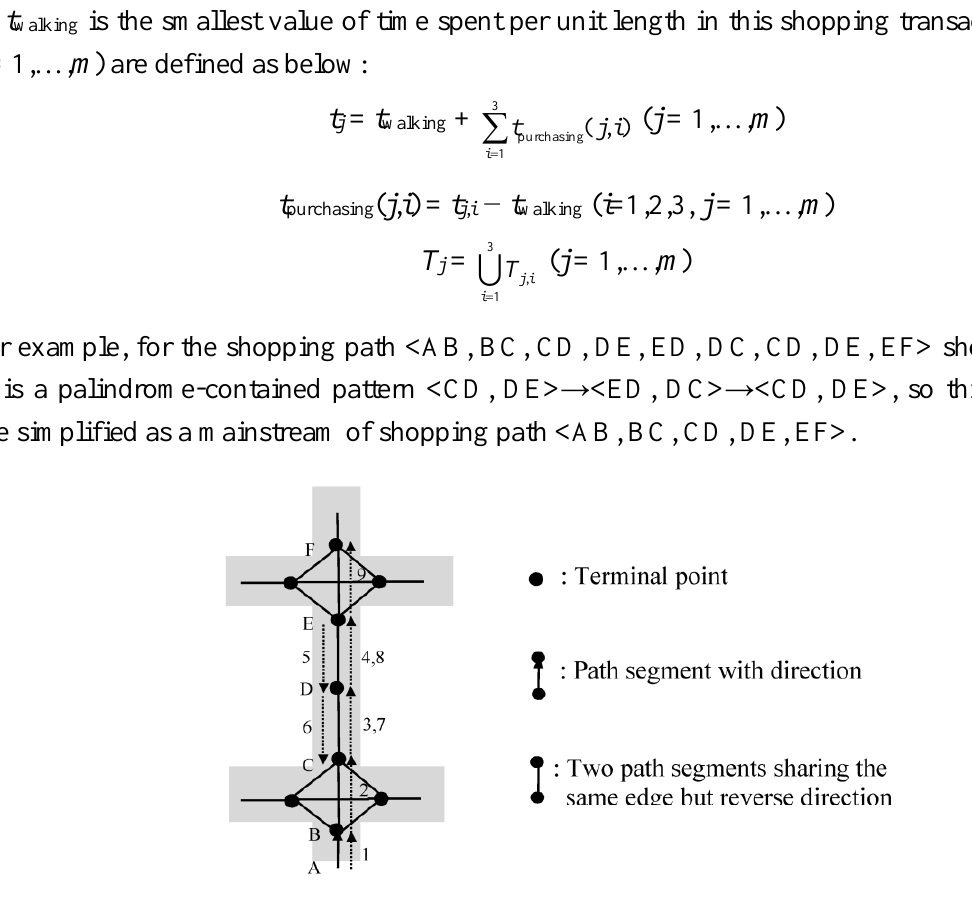
Figure 7. An illustrative example for palindrome-contained